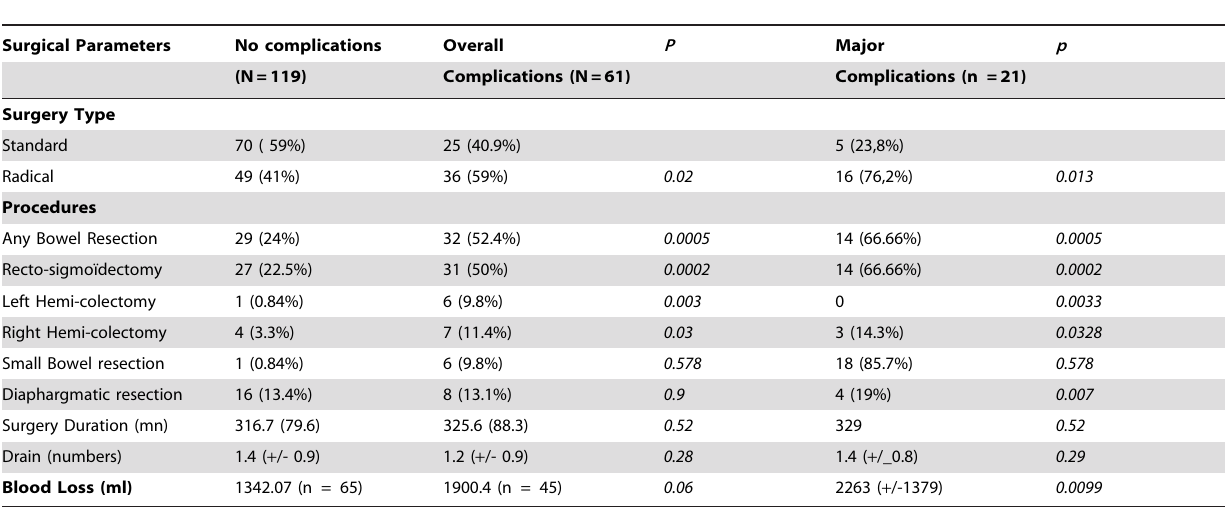
Table 6. Association between procedures and occurrence of a complication.